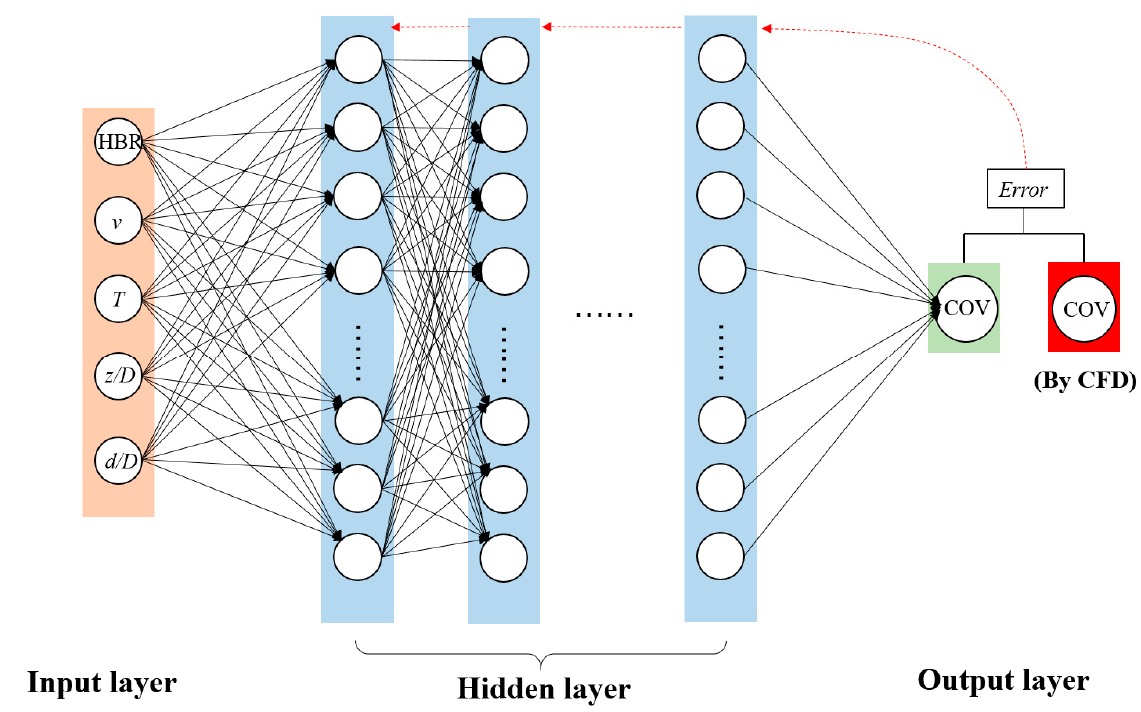
Figure 12. Architecture of established DNN model for COV prediction.